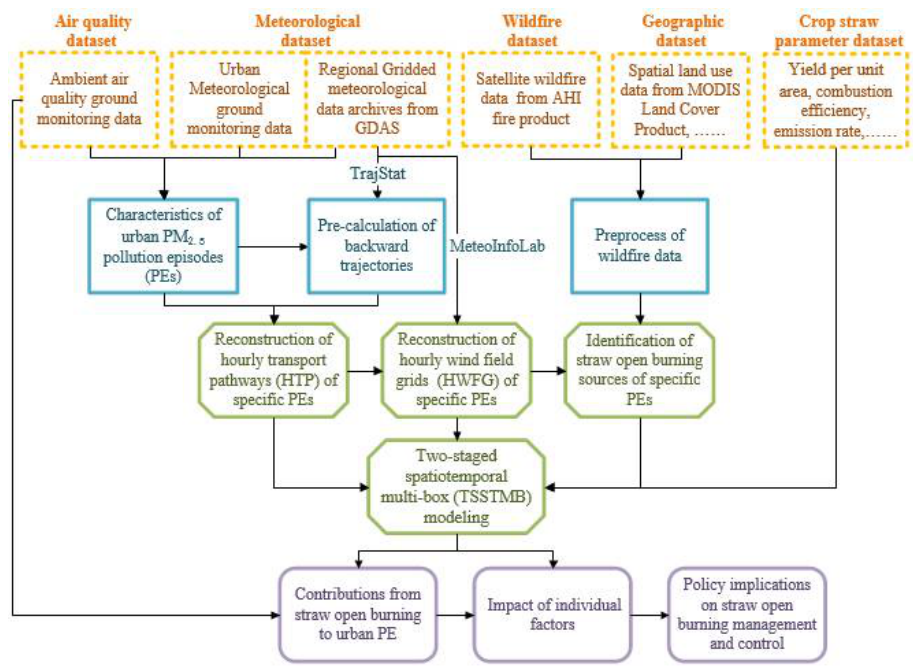
Figure 2. Framework and procedures of the GIS-based integrated method in this study.